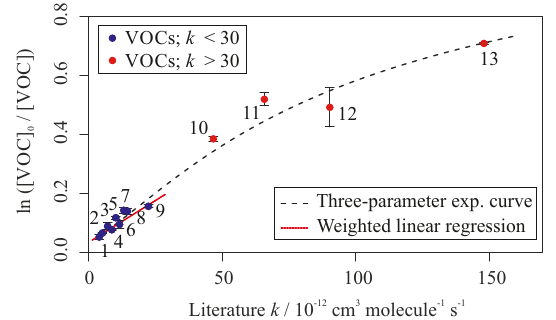
Figure 7. Relative rate plot for Mixture 3 (OH reactivity is 60s − 1 ) at 323K. Compounds with a known rate coefficient are plotted us- ing literature k (323K) values. Error bars on the y axis, equal to 1 standard error, are calculated by combining the standard error in peak areas for five lamp-off samples and five lamp-on samples. See Fig. S5 for a plot displaying x -axis error bars, which are not shown here for reasons of clarity. The black dashed line shows the relation- ship observed when VOC concentrations are low, modelled by an exponential cumulative distribution. A weighted linear fit was used to generate the red slope ( R 2 of 0.976) for VOC with k (323K) less than 30 × 10 − 12 cm 3 molecule − 1 s − 1 . Identities of VOCs: 1, 2,2,3- trimethylbutane; 2, toluene; 3, n -heptane; 4, n -octane; 5, n